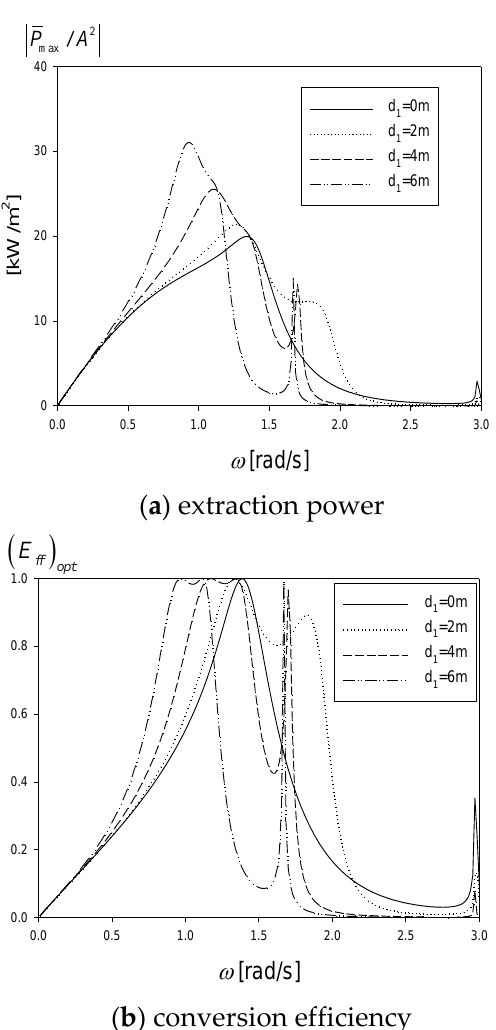
Figure 6. Extraction power ( a ), and conversion efficiency ( b ) at the optimal turbine constant as a function of the barrier height ( d 1 ) for h = 10 m, a = 3 m, d 2 = 3 m, b = 1.5